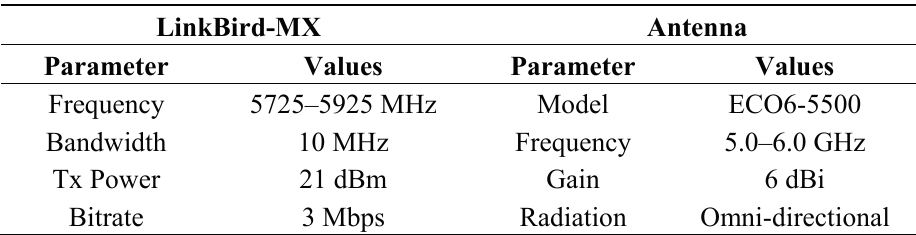
Table 2. Hardware set-up.